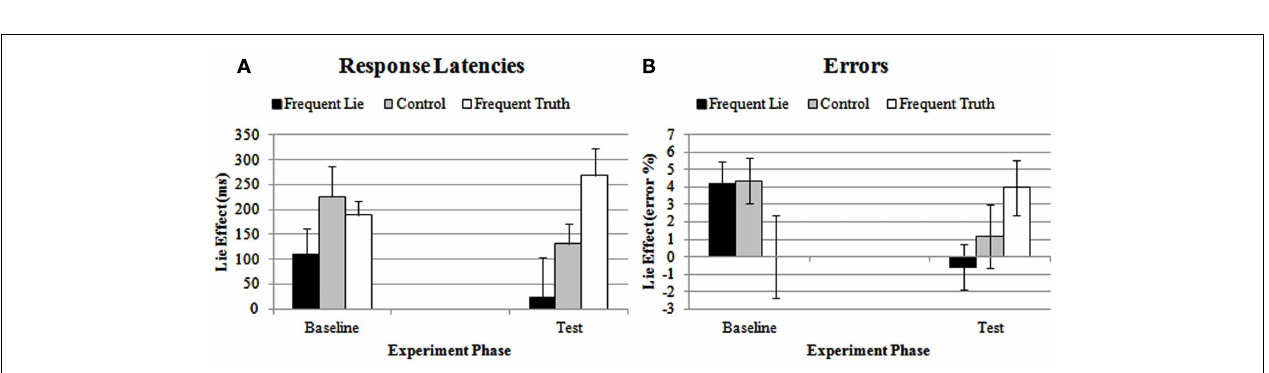
FIGURE 2 | Lie-effect of response latencies (A) and errors (B) on filler trials for the frequent-lie, control, and frequent-truth group, during the baseline phase and the test phase. Error bars represent the standard error of the mean.